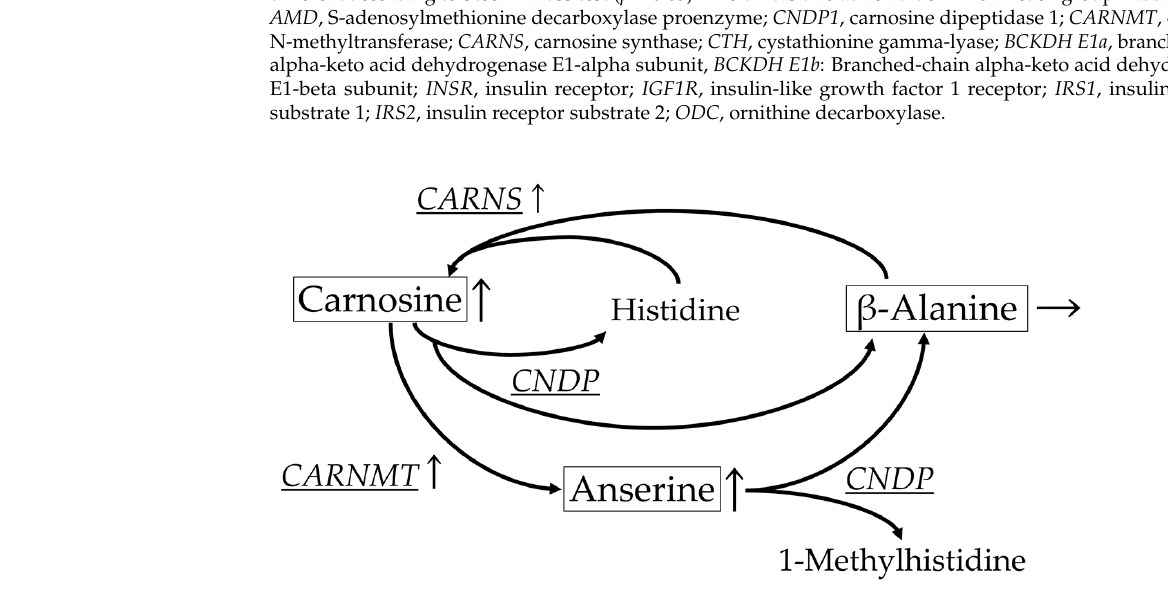
Figure 1. Carnosine-related metabolism during post-hatch developmental period. Boxed metabolites are quantified or semi-quantified metabolites of the breast muscle during the development in chickens. Metabolic enzymes were shown with underbar. Arrows indicate increase ( ↑ ) or no effect ( → ) for each metabolite level or metabolic enzyme mRNA level.